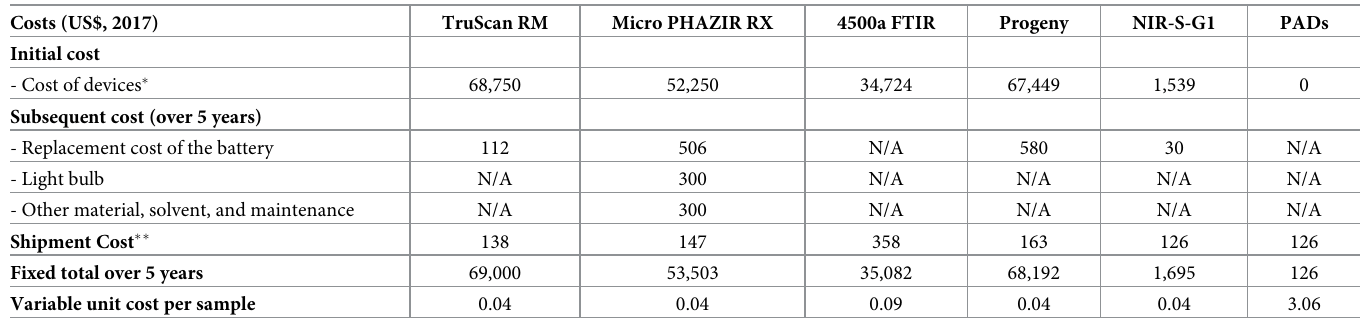
Table 3. Fixed and variable costs of the